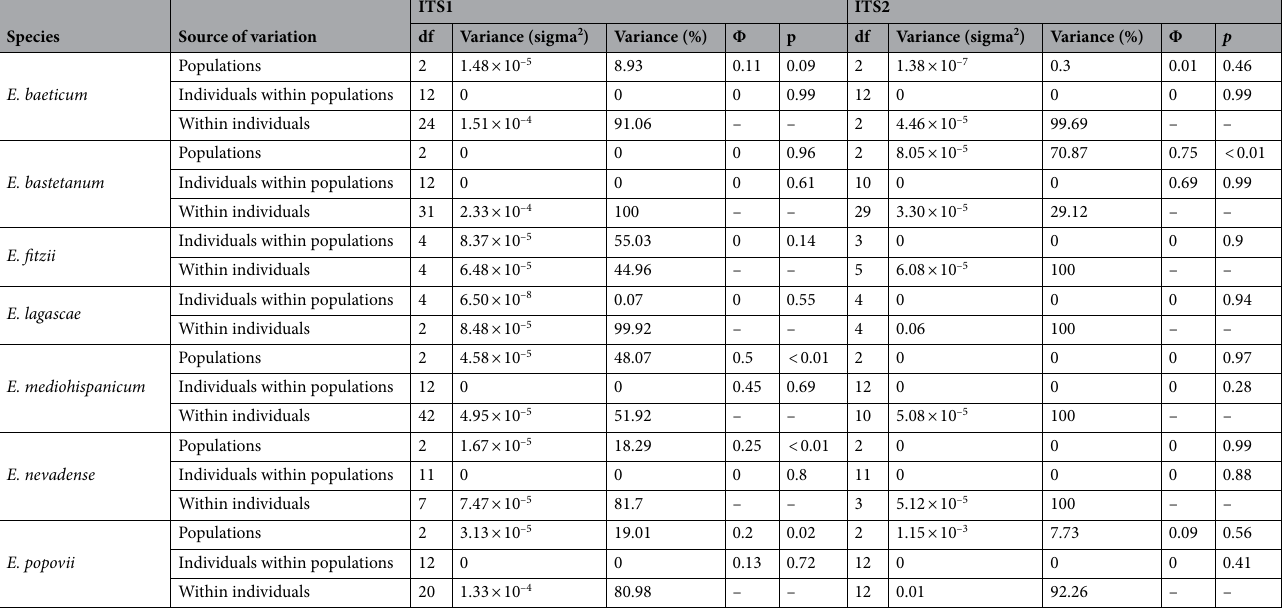
Table 4. ITS1 and ITS2 hierarchical AMOVA results for E. baeticum , E. bastetanum, E. fitzii, E.lagascae, E. mediohispanicum , E. nevadense, and E.